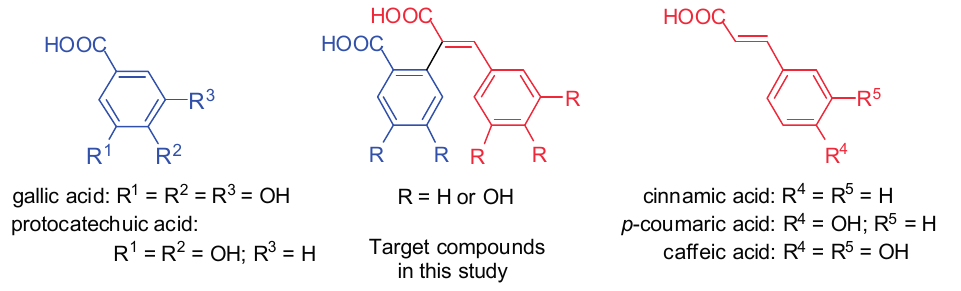
Figure 1. Structure of natural phenolic acids targeted as active fragments for the synthesis of hybrid antioxidants.